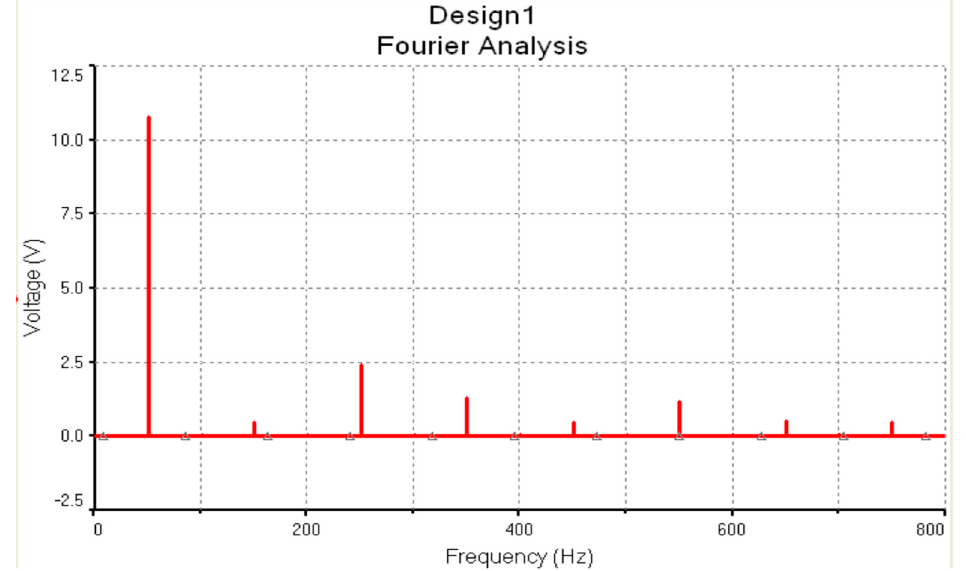
Figure 16. Fourier analysis of 3-level FC- MLI.